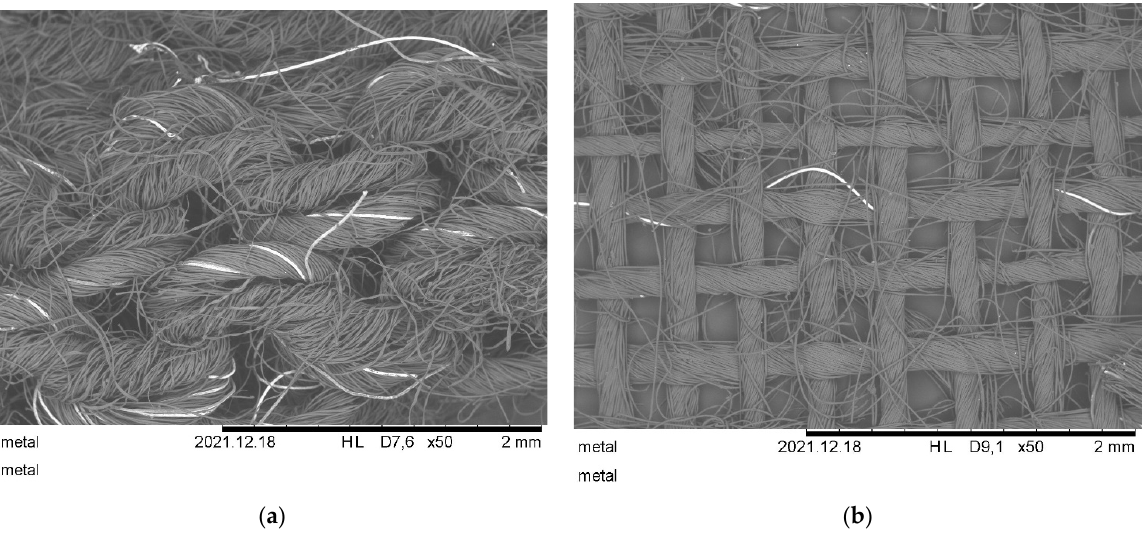
Figure 34. SEM images of two commercial textile products containing silver fibers: ( a ) antimicrobial sock (Go Well MED X-Static); ( b ) woven fabric for electrosmog shielding (Evolution, YShield EMR-Protection).